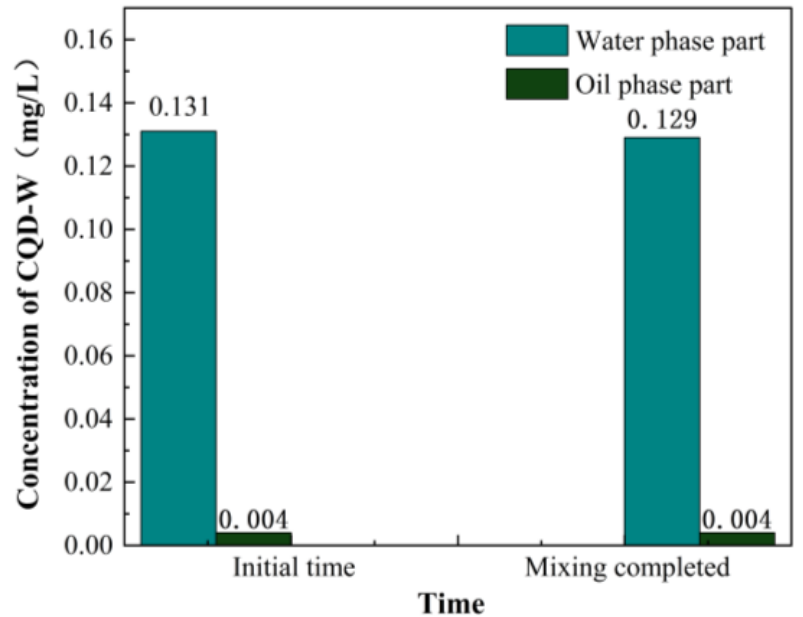
Figure 10. Change in concentration of CQD-W after static stratification of the solution.